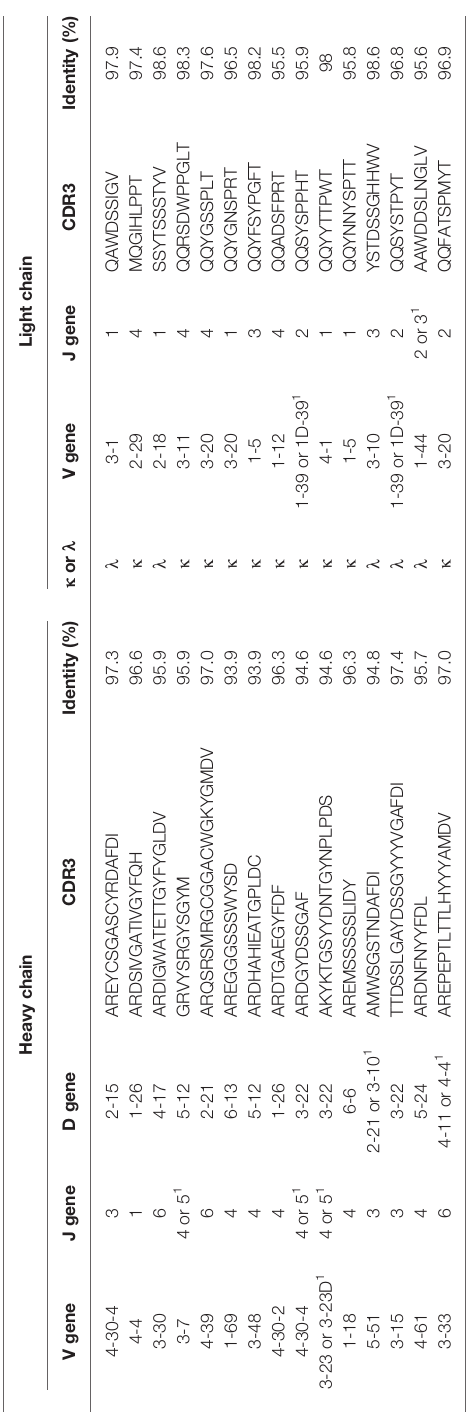
( Figure 2B ) and is the functional epitope of LB_DQB0301_A ( Figure 2C ). While the antibody-veri fi ed eplet 45EV (45E 46V 47Y) was identi fi ed by HLAMatchmaker analysis as